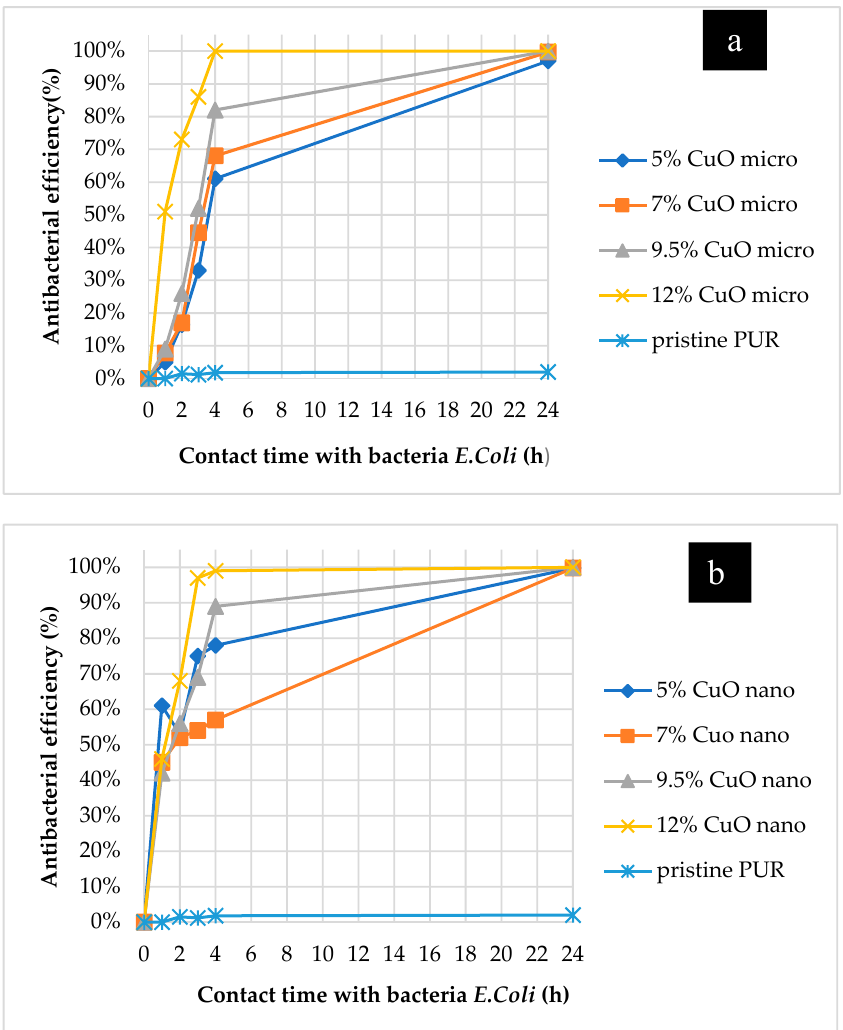
Figure 9. Changing of antibacterial efficiency against E. coli over time for samples with microparticles ( a ) and nanoparticles of CuO ( b ) produced from rotating electrode with a needle surface.